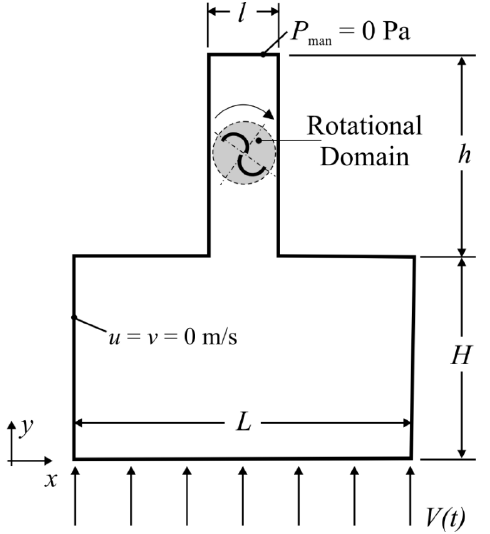
Figure 2. Schematic representation of Case 2 and Case 3 that simulate the OWC with a Savonius turbine.